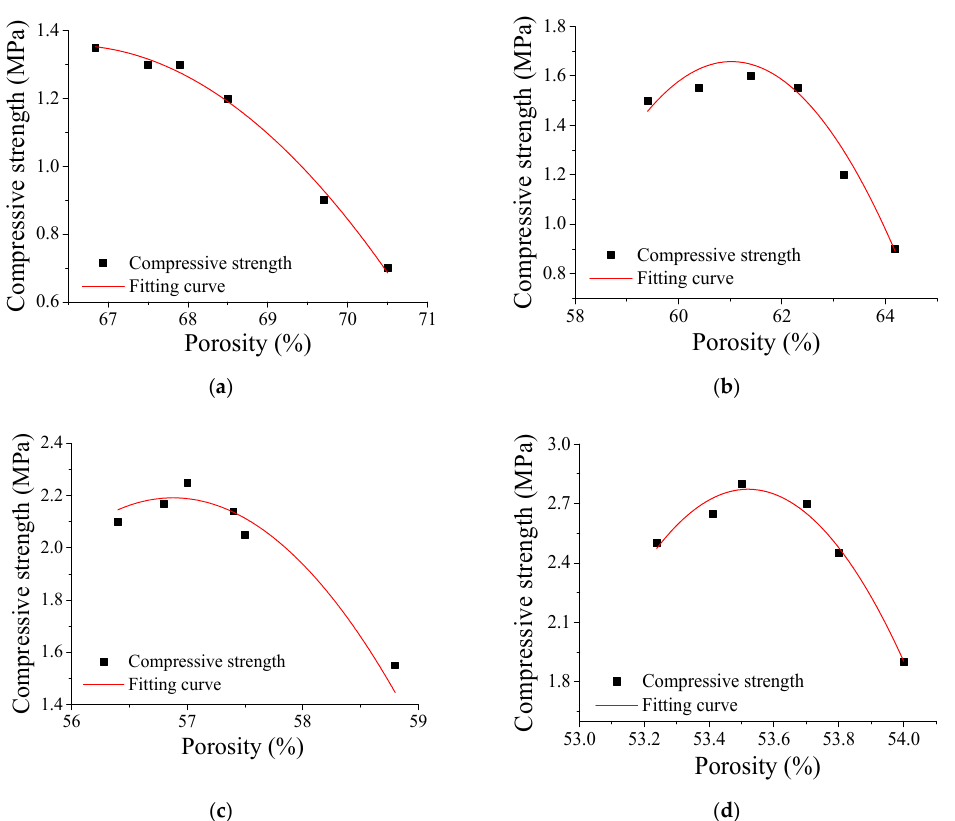
Figure 5. Correlation between porosity and compressive strength. ( a ) 600 kg / cm 3 foamed concrete; ( b ) 700 kg / cm 3 foamed concrete; ( c ) 800 kg / cm 3 foamed concrete; ( d ) 900 kg / cm 3 foamed